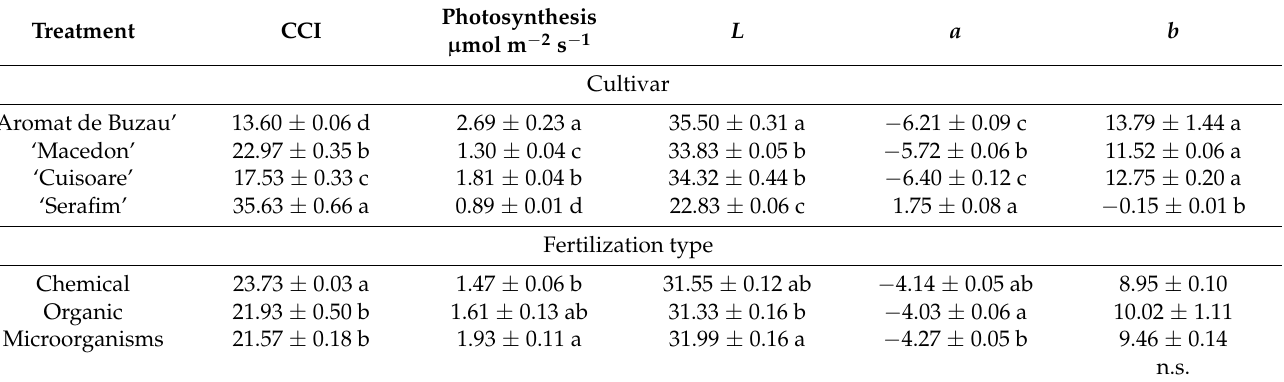
Table 6. Influence of cultivar and fertilization type on physiological and color